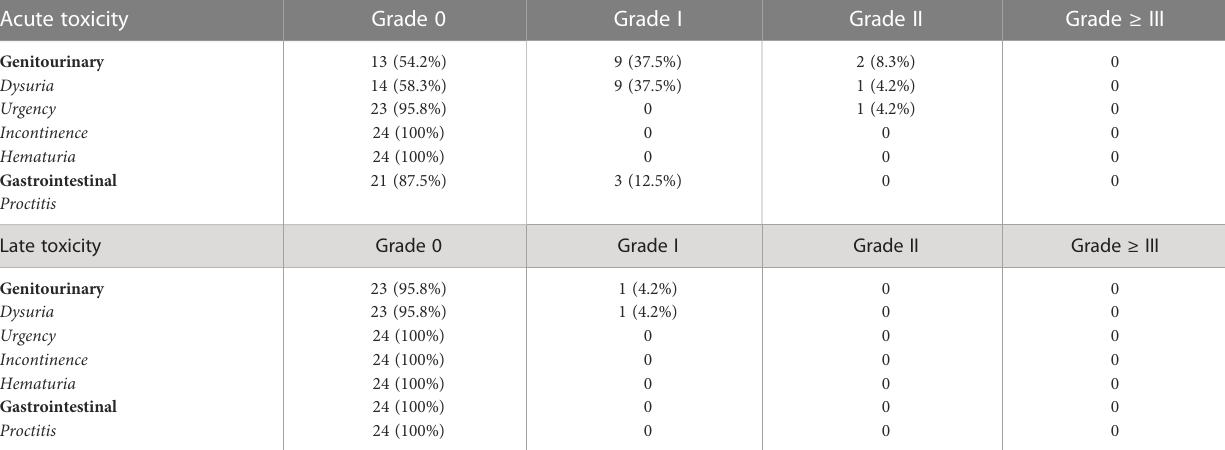
TABLE 3 Cumulative acute and late toxicity.